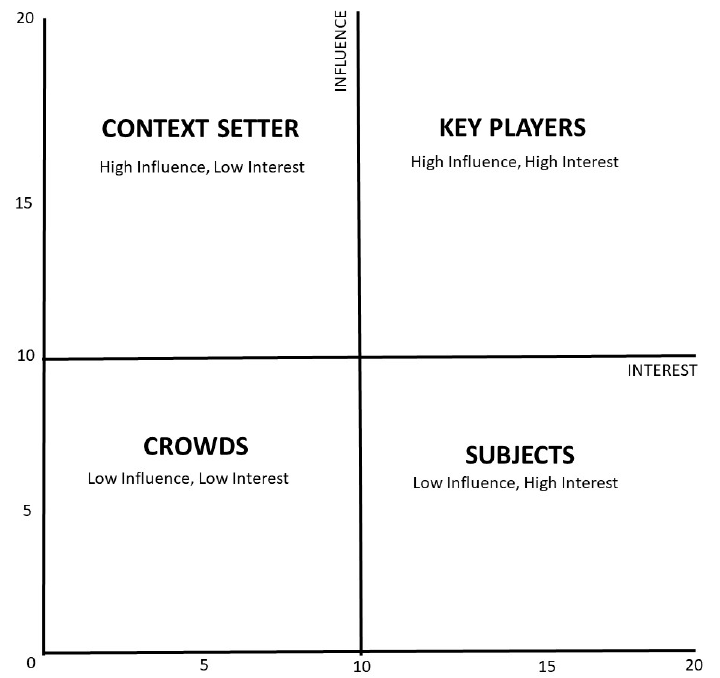
Figure 2. Adapted and modified grid [21,22] for stakeholder identification, which divides the stake- stakeholder groups based on their influence and interest. holder groups based on their influence and interest.